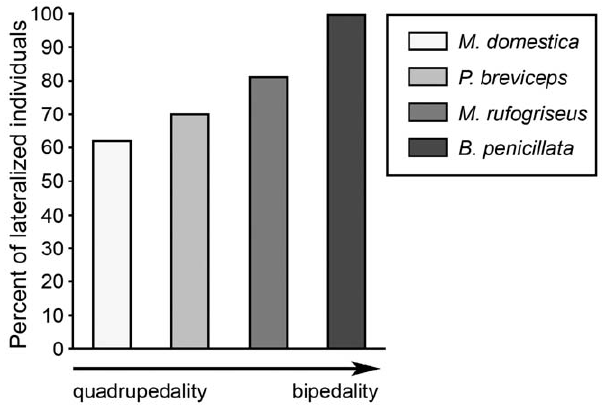
Figure 3. Percentage of lateralized individuals in marsupial species characterized by different degree of bipedality. The bars represent the percent of the subjects showed significant forelimb preferences for unimanual feeding on non-living food in grey short- tailed opossums, Monodelphis domestica ( n =26) [13], sugar gliders, Petaurus breviceps ( n = 23) [13], red-necked wallabies, Macropus rufogriseus ( n =27) [49], and brush-tailed bettongs, Bettongia penicillata ( n =12) (the present study). The arrow indicates the increase of relative degree of bipedality and body verticality from grey short-tailed opossums – terrestrial quadrupeds rarely observed in a bipedal position and sugar gliders – arboreal quadrupeds frequently feeding in a bipedal position [13] to red-necked wallabies – bipedal saltators, but moving quadrupedally at slow speeds and brush-tailed bettongs, which prefer bipedal hopping even at the slow speed (see Discussion for a